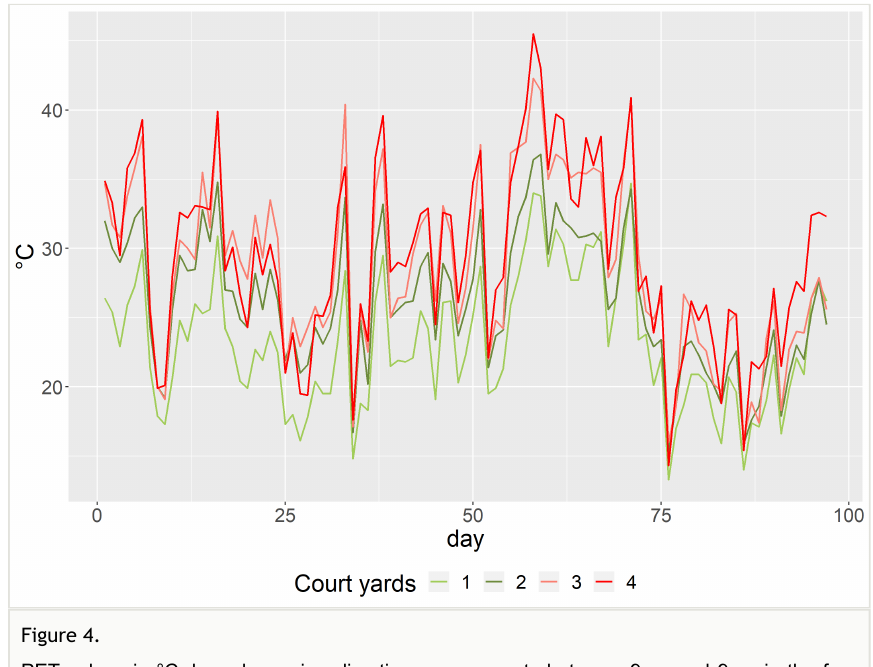
PET values in °C, based on microclimatic measurements between 9am and 9pm in the four courtyards.